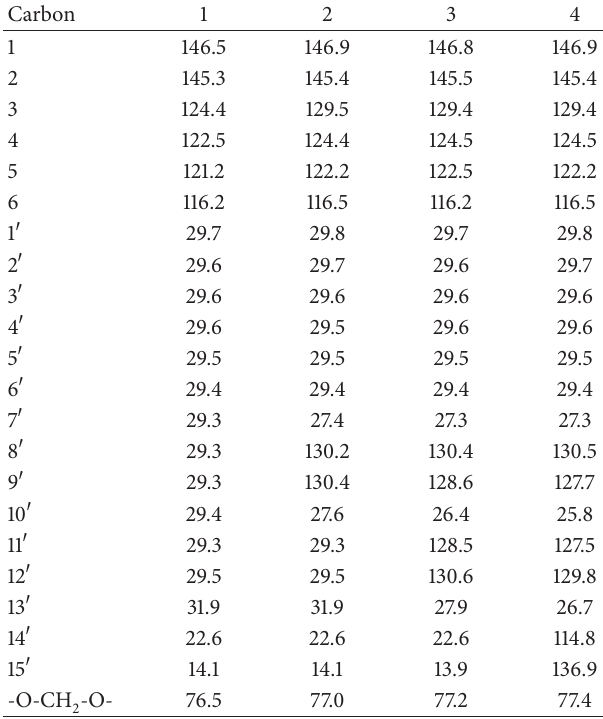
Table 1: 13 C NMR spectral data of compounds 1, 2, 3, and 4 in ( 𝛿 pyridine-d 5